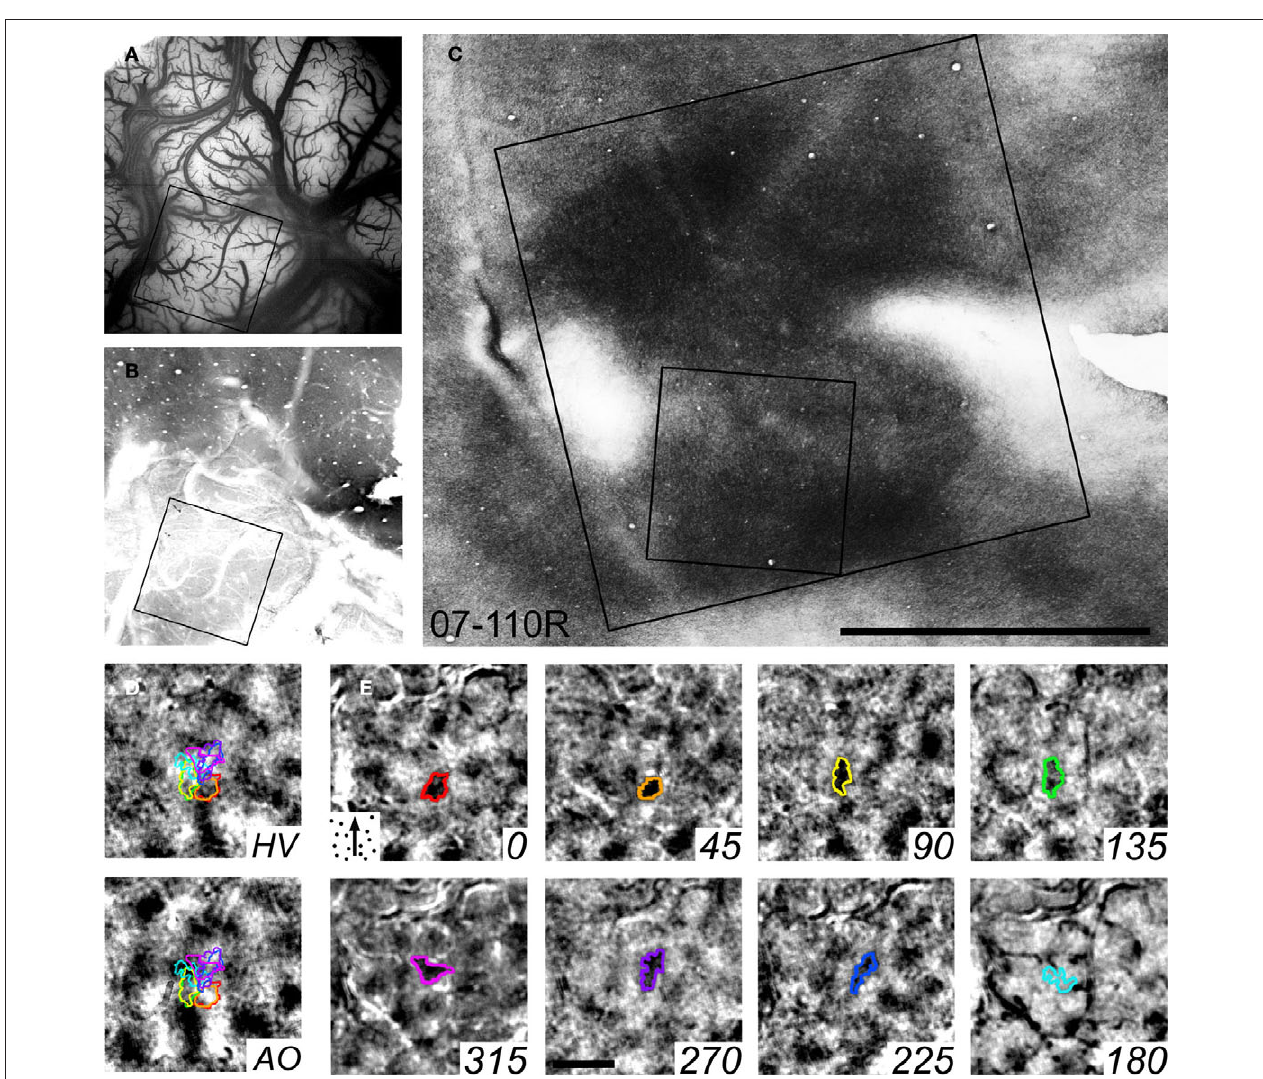
Figure 3 | The activation of MT by drifting gratings and random dots in case 07-110r. (A) A photograph of the surface of the brain, taken in vivo . (B) The corresponding section of the flattened cortex stained with cytochrome oxidase (CO) preserves the surface blood vessel pattern. The field of view of (A,B) is 8 mm × 8 mm. (C) A section of the flattened cortex stained with myelin to reveal the borders of MT. White regions correspond to superficial cortical layers that stain weakly for myelin, as the sectioned cortex was not completely flat to the superior temporal sulcus on the right and a dimple along a blood vessel on the